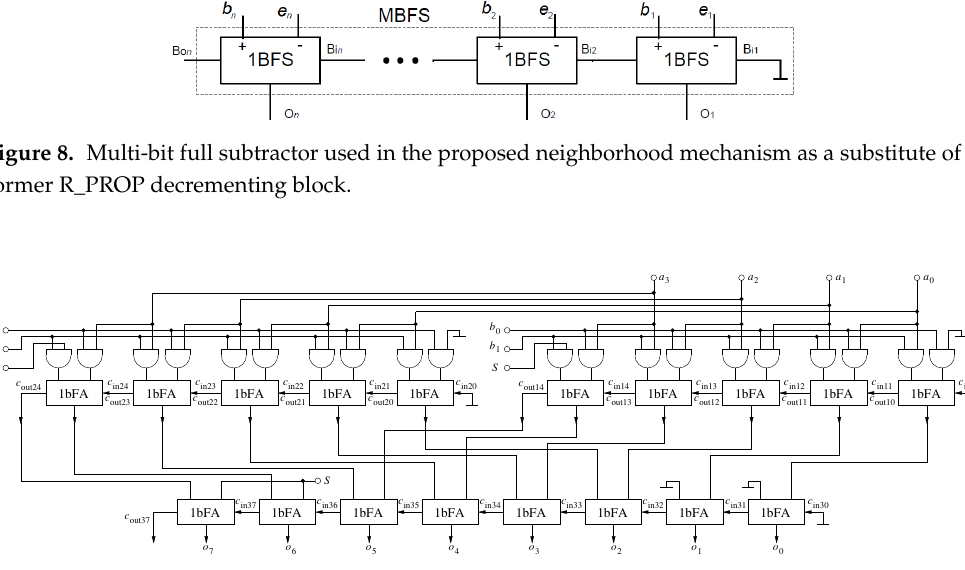
Figure 9. Binary-tree (BT) asynchronous multiplier used in the proposed solution for an example case of two 4-bit numbers. For S = 0 the circuit works as multiplier of two positive numbers (A, B = 0, . . . , 15). For S = a 3 the A variable is expressed in two’s complement notation (A = − 8, . . . , 7). The second case is suitable to perform the multiplication in Formula